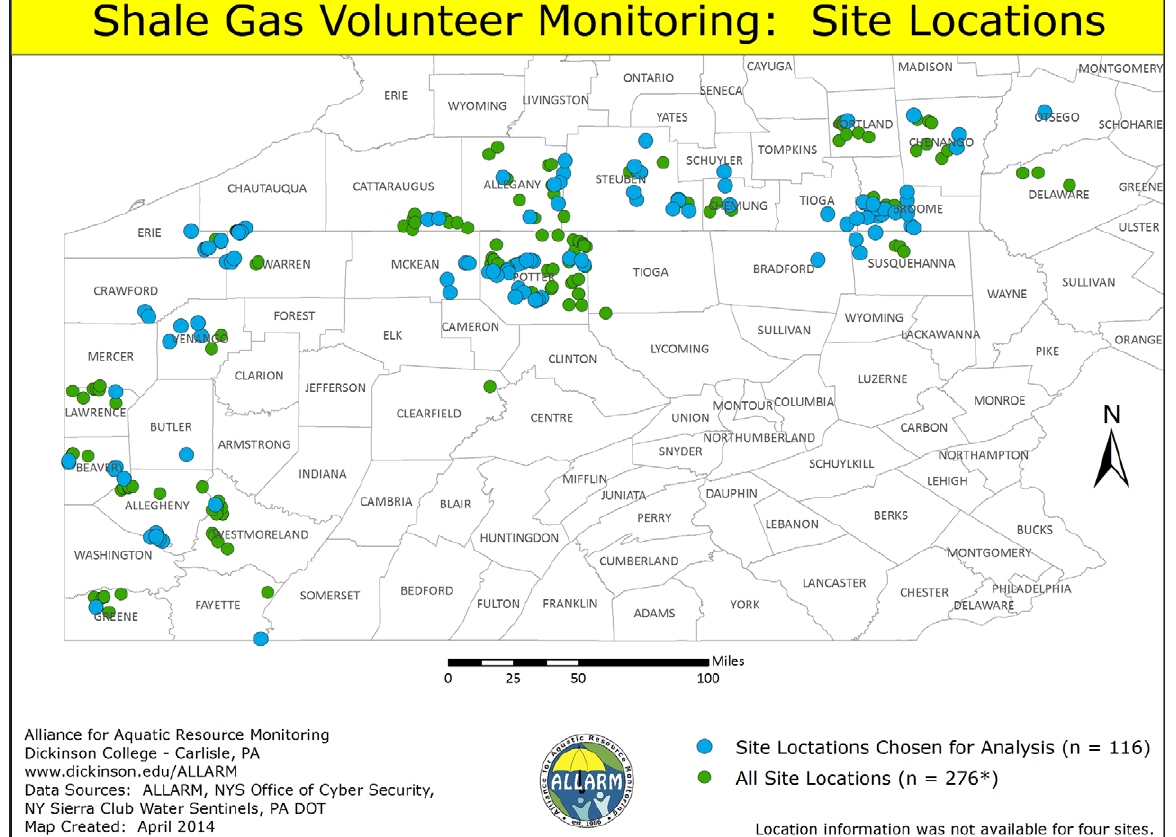
Figure 7: Map of Pennsylvania and the southern tier of New York showing all site locations for which data were compiled, with blue designating the locations of sites that fit the criteria for inclusion in the data analysis.